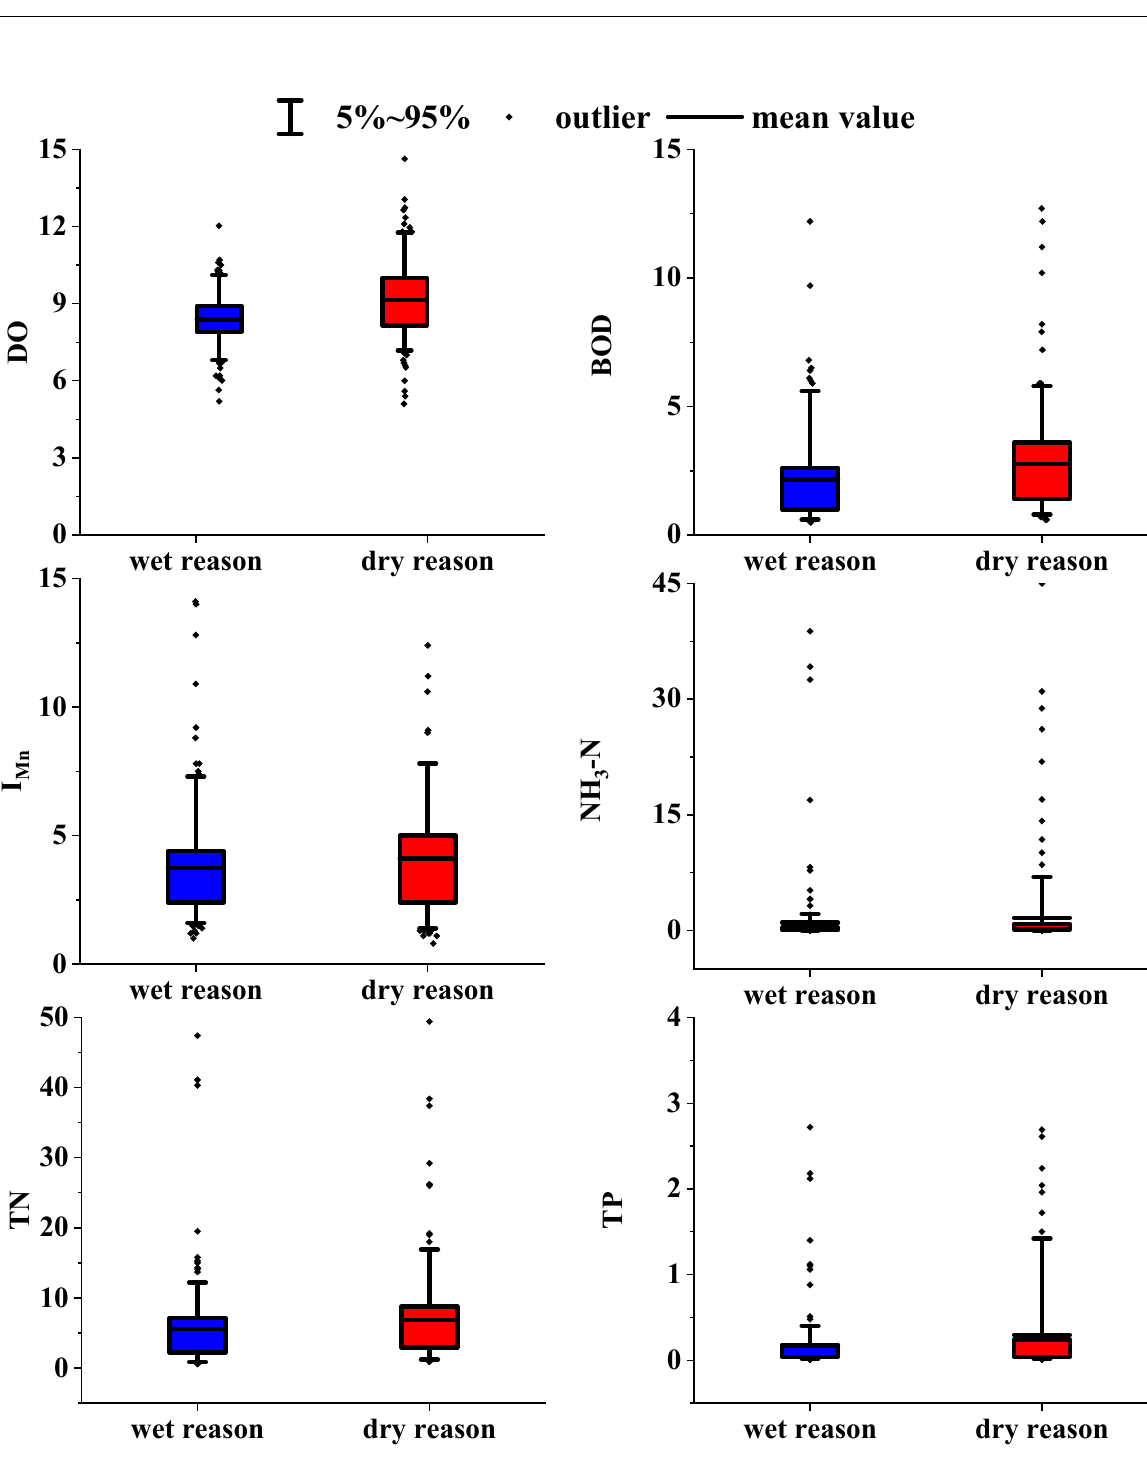
Figure 3. Box plot of the water quality in the wet season (from July to October) and dry season (From March to June).